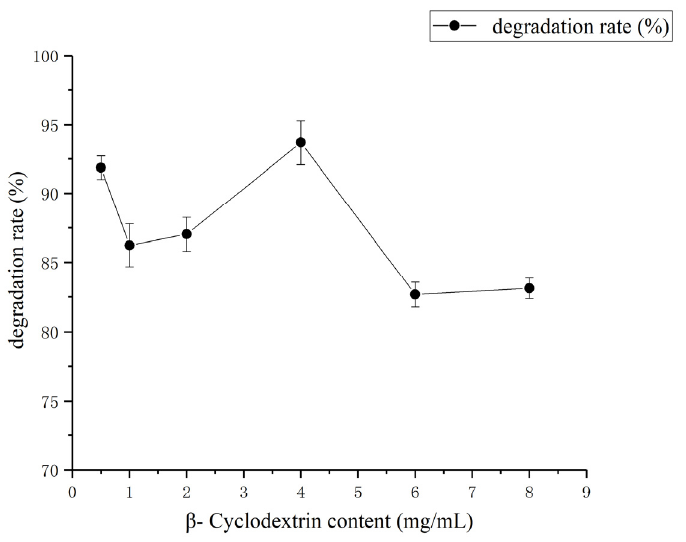
Figure 8. Effect of β -cyclodextrin content on coumarin degradation rate. The results are expressed as the mean ± SD from three independent experiments.